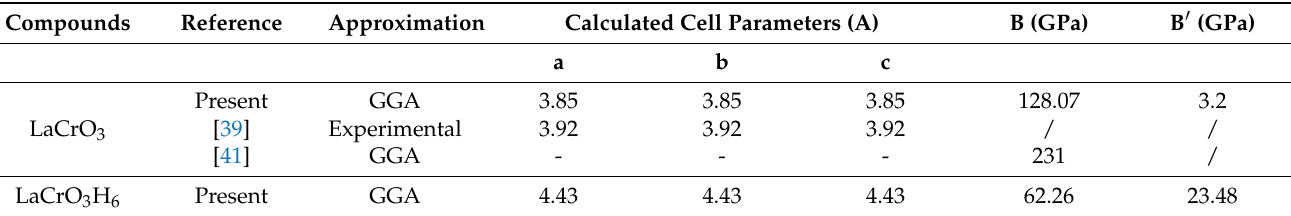
Figure 2. Total energy (Ry) vs. unit cell volume for LaCrO 3 H 6 . Table 2. Cell parameters, mechanical properties of LaCrO 3 and LaCrO 3 H 6.